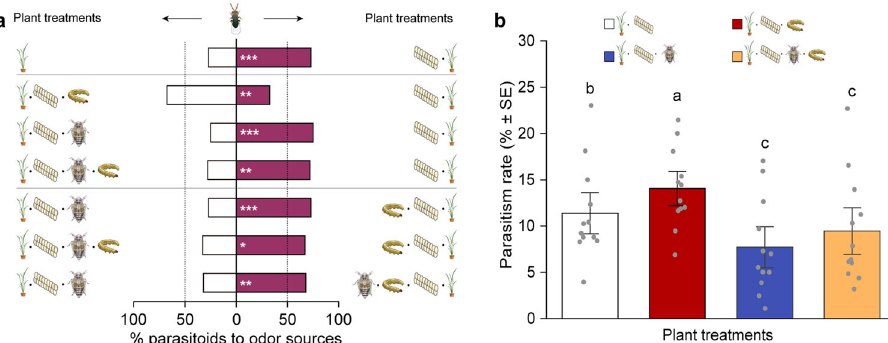
Fig. 7 Preferences of females of the egg parasioid Trichogramma japonicum . a Choice of T. japonicum wasps when offered the odor of differently treated plants in a Y-tube olfactometer. Bars represent the percentages of wasps choosing either of the odor sources. Asterisks indicate signi fi cant differences from a 50:50 distribution (binomial test: * P < 0.05, ** P < 0.01, *** P < 0.001; n = 58 – 80) Exact P -values and number of replicates were as following: P = 5.84e-04, n = 59 (plants with eggs vs uninfested plants); P = 2.32e-03, n = 80 (plants with SSB and eggs vs plants with eggs); P = 6.74e-05, n = 67 (plants with eggs vs plants with BPH and eggs); P = 1.07e-03, n = 60 (plants with eggs vs plants with SSB, BPH, and eggs); P = 1.42e-04, n = 73 (plants with SSB and eggs vs plants with BPH and eggs); P = 0.012, n = 58 (plants with SSB and eggs vs plants with SSB, BPH, and eggs); P = 8.64e-03, n = 59 (plants with SSB, BPH, and eggs vs plants with BPH and eggs). b Parasitism rates of SSB eggs by T. japonicum in the greenhouse experiments. Exact P- values = 4.47e-04 (Control vs SSB), 2.13e-08 (Control vs BPH), 2.79e-11 (Control vs SSB/BPH), <1e-04 (SSB vs BPH), <1e-04 (SSB vs SSB/BPH), and 0.14 (BPH vs SSB/BPH). Each bar represents the mean ± SE. Signi fi cance was determined by two-sided likelihood ratio test with generalized lineal model (binomial distribution error). Different letters above bars indicate signi fi cant differences between treatments ( P < 0.05; n =